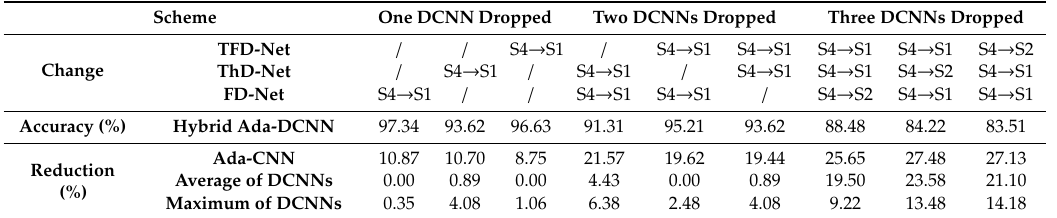
Table 8. Performance of the hybrid Ada-DCNN, Ada-DCNNs, and DCNNs under di ff erent schemes (“ / ” represents no